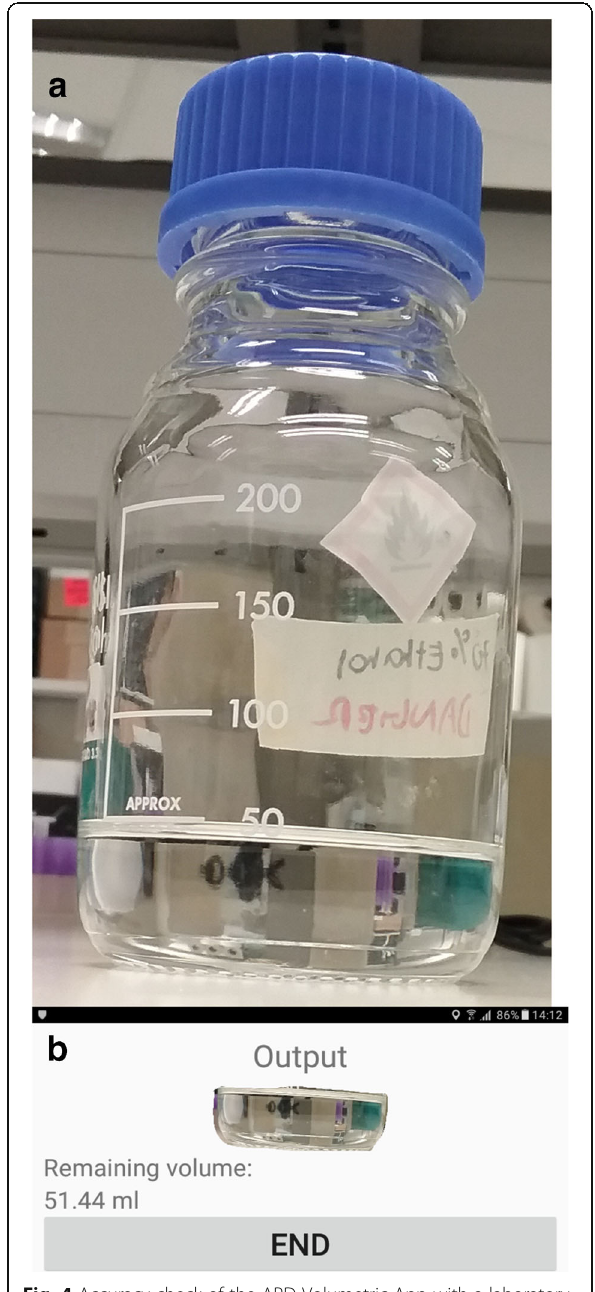
Fig. 4 Accuracy check of the APD Volumetric App with a laboratory beaker. a Image of 50 mls in a lab beaker. b Quantification of 50 mls in the lab beaker as 51.44 ml using APD Volumetric